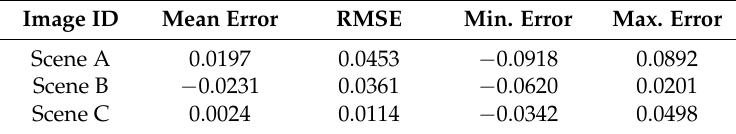
Table 5. Statistical results of the fitting residuals (unit: pixel).